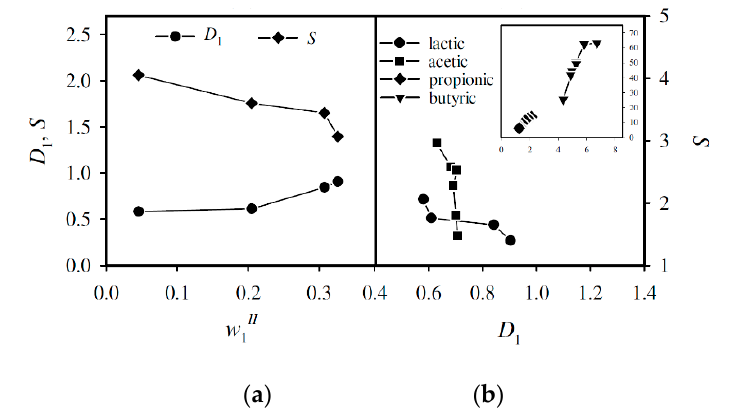
Figure 4. ( a ) Distribution coefficient, D 1 , and separation factor, S , against the mass fraction of lactic acid in the aqueous phase at T = 308.15 K and P = 0.1 MPa (atmospheric pressure); ( b ) S as a function of D 1 . Data for acetic, propionic, and butyric acids were calculated from Belgodere et al. [28].